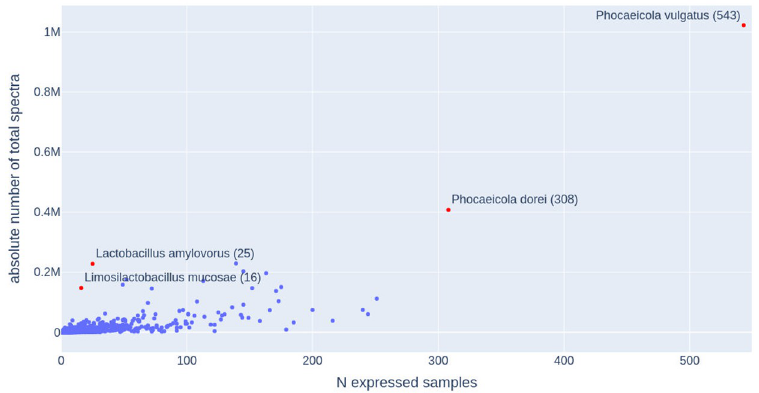
Fig 1. Scatter plot summarizing the expression of 2,511 human associated microbial genomes in different samples. X-axis shows the number of samples in which each genome was observed, and y-axis shows the total support spectra for each genome. The four “outlier” genomes that are highly expressed and/or broadly distributed are highlighted in red with their species names shown in the plot, followed by the number of samples supporting their expression in the